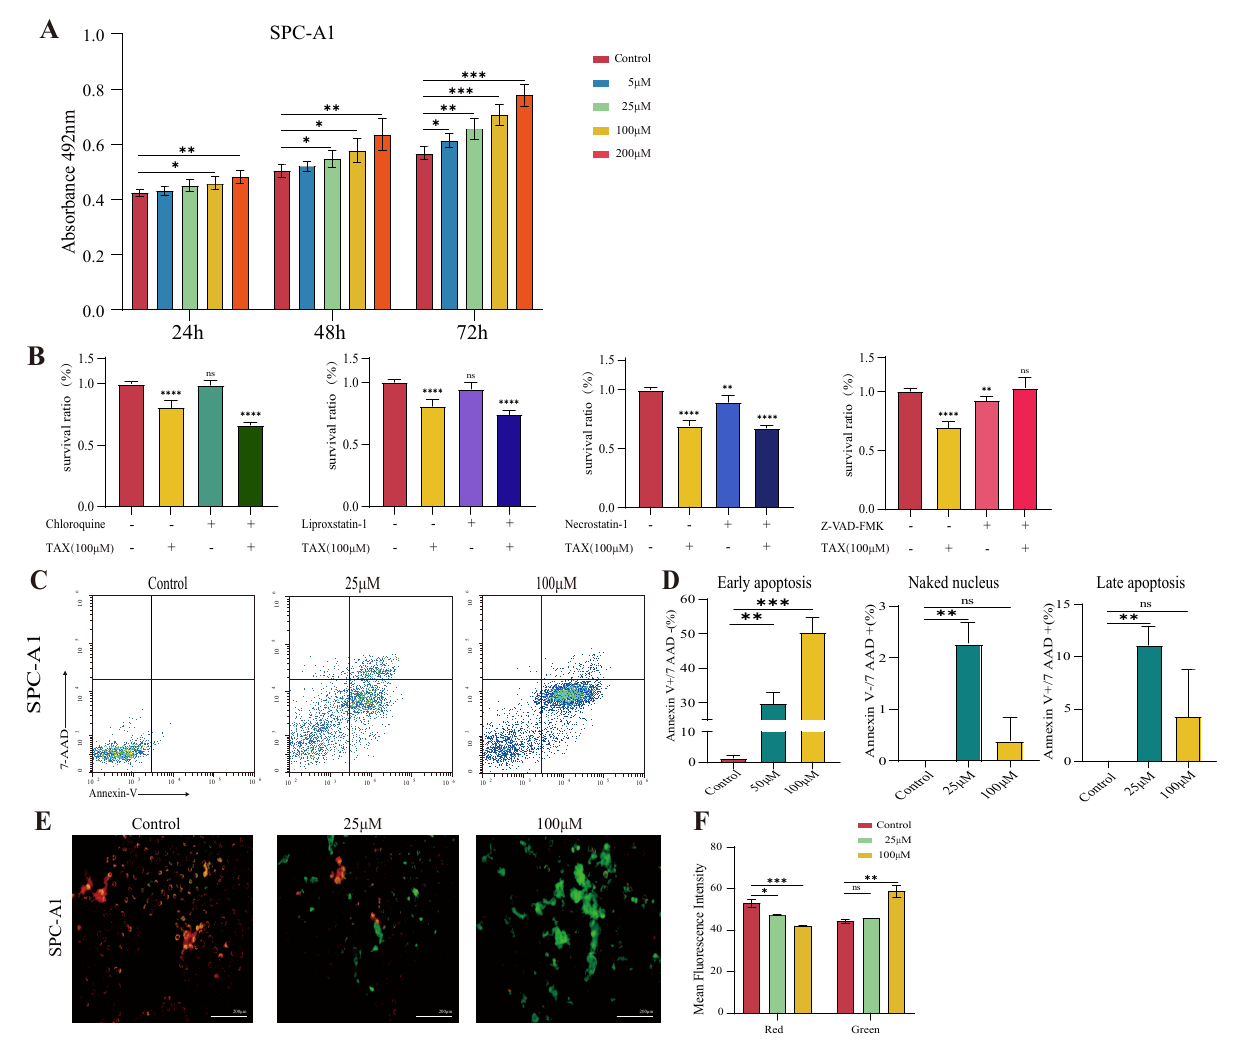
Figure 4. TAX induces the apoptosis of lung cancer cells: ( A ) After SPC-A1 cells were treated with different concentrations of TAX for indicated time periods, LDH release assay was carried out and the absorbance was measured at 492 nm. ( B ) TAX was treated with chloroquine (CQ 25 µ M, a potent inhibitor of autophagy), Liproxstatin-1 (Lip 8 µ M, a potent ferroptosis inhibitor), necrostatin-1 (Nec-1 10 µ M, a potent inhibitor of necroptosis) and Z-VAD-FMK (10 µ M, a pan-caspase inhibitor). CCK-8 assay was carried out and the absorbance was measured at 450 nm, and inhibition ratio was calculated. ( C , D ) SPC-A1 cells were double-stained with FITC annexin V/7-AAD fluorescence after the treatment of TAX for 48 h to detect early apoptosis, and the percentage of cells in early or late apoptosis was obtained and statistically analyzed. ( E , F ) The mitochondrial membrane potential alteration in SPC-A1 cells treated with TAX for 48 h was detected using fluorescence microscopy, and the shift of JC-1 dye from red-to-green fluorescence was a signal of early apoptosis, and the images were quantified and statistically analyzed. Scale bar: 200 µ m. ns, not significant, * p < 0.05, ** p < 0.01, *** p < 0.001, **** p < 0.0001. (Student’s t -test). Data are presented as mean ±